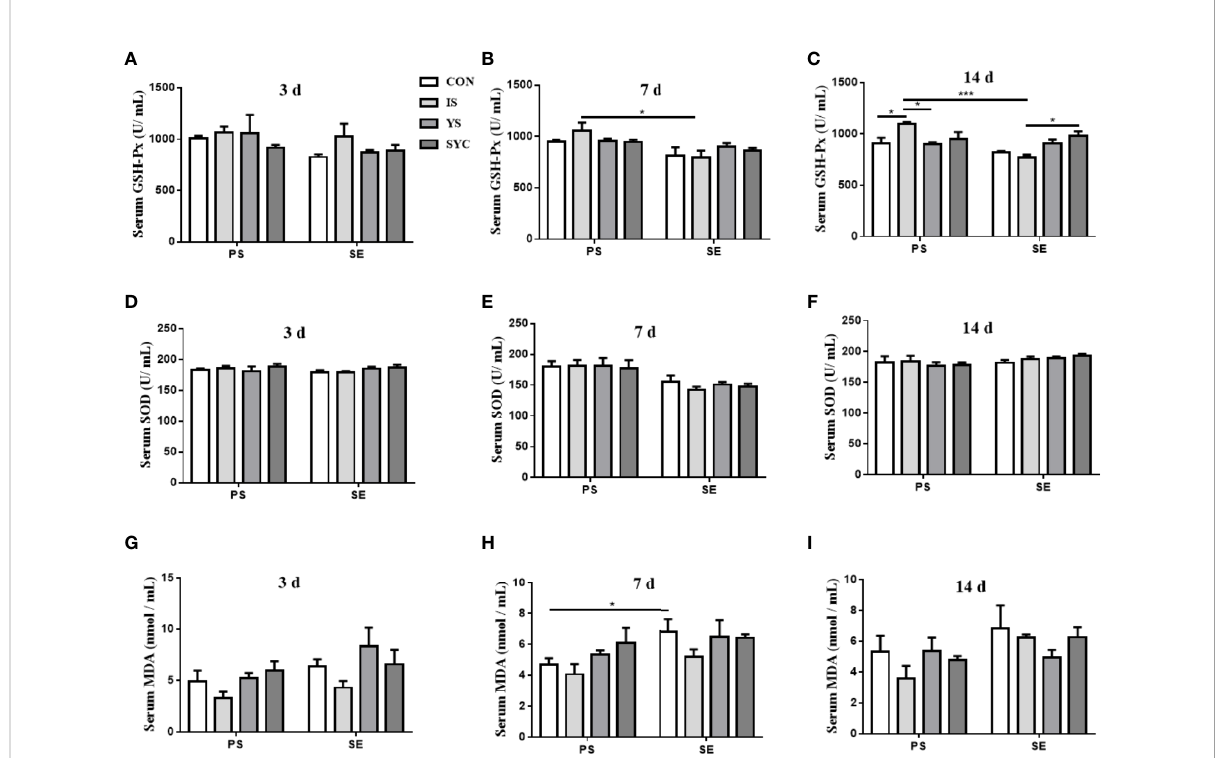
FIGURE 2 Effects of dietary supplementation with different Se sources on the serum antioxidant status of layers challenged with S. Enteritidis . CON, basal diet; IS, sodium selenite; YS, yeast selenium; SYC, selenium-enriched yeast culture; PS, challenged with physiological saline solution; SE, challenged with S. Enteritidis . The levels of serum GSH-Px, SOD, and MDA were measured among different periods and treatments (A – I) . The data were presented as mean ± SEM. Signi fi cance was compared with every other group; * P < 0.05, *** P < 0.001.